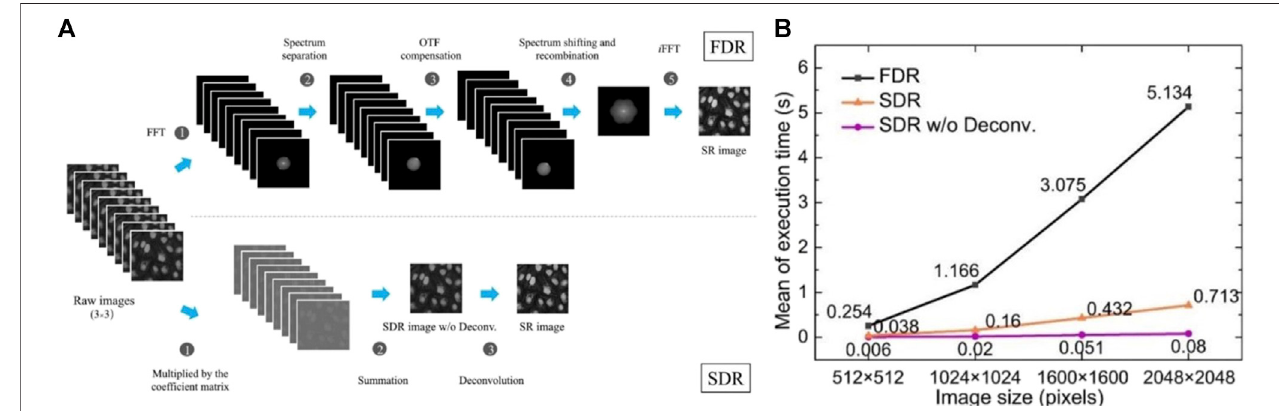
FIGURE 9 | SDR generates SR images 64-fold faster than FDR [71]. (A) The comparison of the FDR and SDR image reconstruction schemes. Top line, the FDR work fl owneedsthe fi vestepstoattainasuper-resolutionimage.Bottom line,SDRisintrinsicallysimpler,whichisonly3-step work fl ow. (B) Thecomparisonofthemean executiontime betweendifferentreconstructionschemes.Themeanvalueoftheexecution timeforSDRwithoutdeconvolution isupto64timesfaster